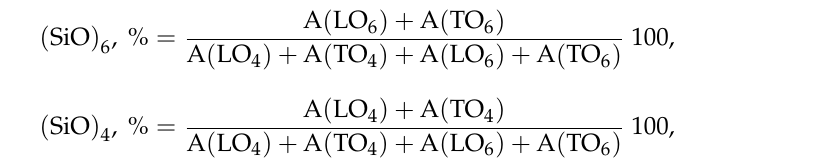
Figure 7. Deconvolution and least-squares adjustment of the FTIR spectra of the xerogels: ( a ) Refer- ence material (100% TEOS), ( b ) 20% ClMTEOS, ( c ) 20% ClETEOS, and ( d ) 20% ClPTEOS. Based on the integrated areas of the Gaussian-Lorentzian bells, Equations (6) and (7) were calculated to determine the relative abundance of (SiO) 6 and (SiO) 4 rings (Tables S3 and S4 for the ClRTEOS:TEOS and RTEOS:TEOS series, respectively).